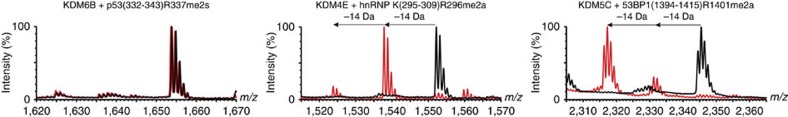
KDMs catalyse demethylation of arginine residues in non-histone substrates.MALDI-TOF MS assays for demethylation of non-histone arginine methylated peptides by KDMs. Red spectra show reactions including enzyme and black spectra the no-enzyme controls.